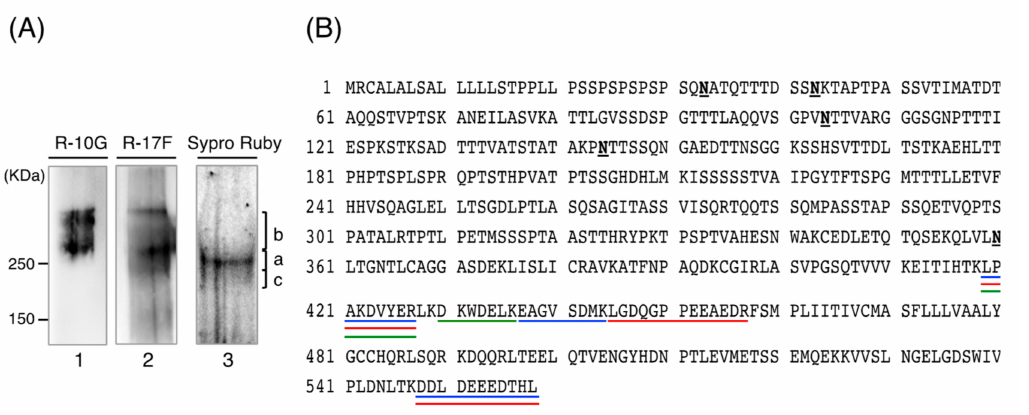
Figure 3. Identification of the R-10G-binding protein as podocalyxin by LC-MS/MS. ( A ) Western blotting using R-10G and SYPRO Ruby staining. Purified R-10G-binding protein (3 ng protein in lanes 1 and 2, 10 ng protein in lane 3) was resolved by SDS-PAGE on a 4–15% gradient gel under reducing conditions. Lanes 1 and 2 show the results of Western blotting using R-10G and R-17F respectively, and lane 3 shows SYPRO Ruby staining. The protein bands a, b, and c were excised from the gel and analyzed by LC-MS/MS. Protein concentrations were estimated based on the SYPRO Ruby staining intensity in comparison with two concentrations of standards from the High-Molecular-Weight SDS Calibration Kit for Electrophoresis (Amersham Pharmacia Biotech). ( B ) Identification of R-10G antigen by LC-MS/MS. The identified peptides in band “a” are underlined in blue within the complete human podocalyxin sequence. Those in band “b” are underlined in orange and those in band “c” in green. N, potential N-glycosylation